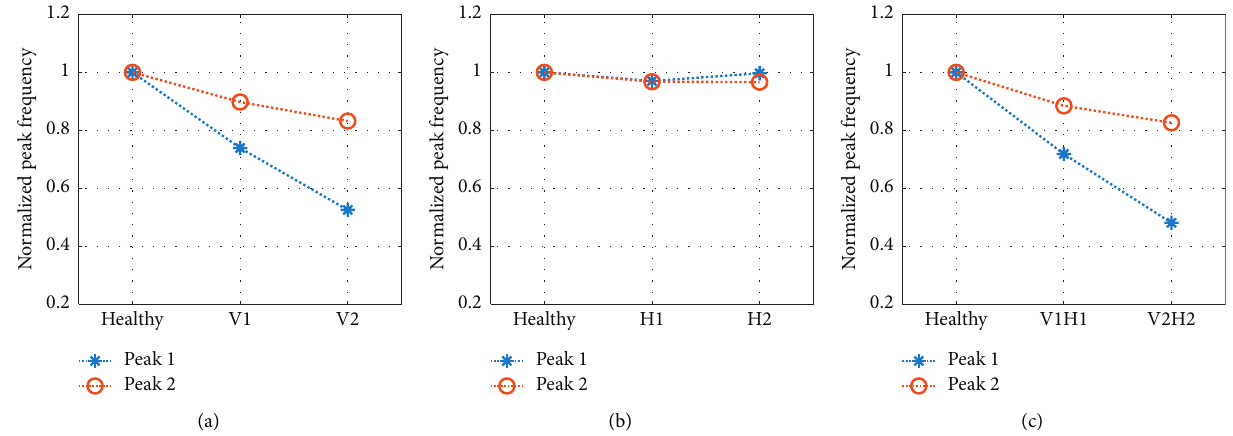
Figure 28: Shifts in peak frequencies due to interface detaching defects. (a) Cases: V1, V2. (b) Cases: H1, H2. (c) Cases: V1H1, V2H2.